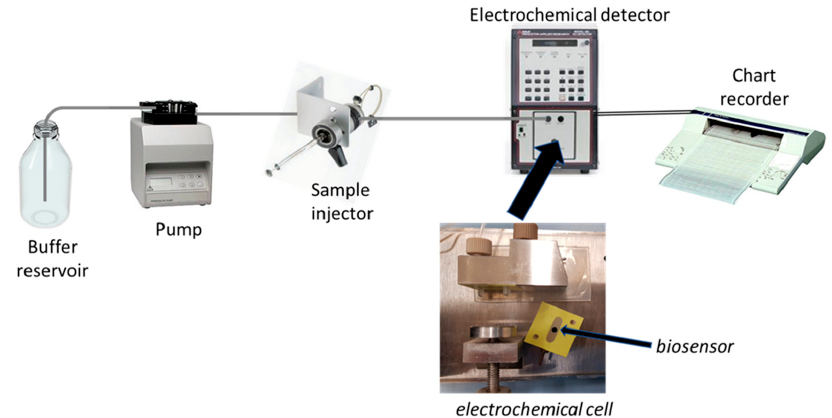
Schematic diagram of the flow injection setup used in the kinetic measurements showing the electrochemical cell and the relevant enzyme modified electrode (biosensor) used in the amperometric